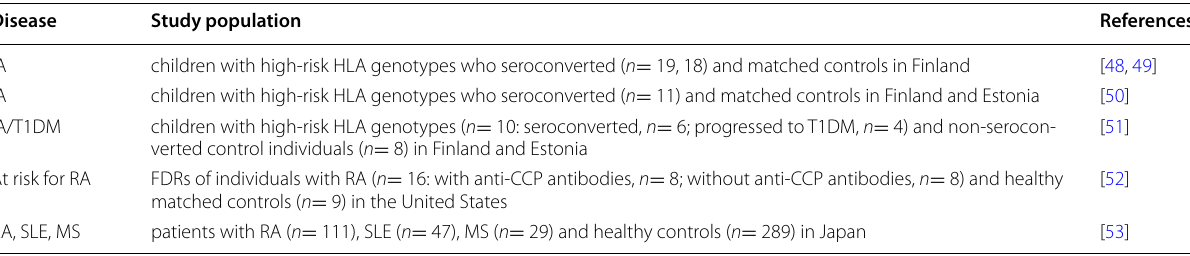
Table 2 Human studies of the intestinal virome in autoimmune diseases